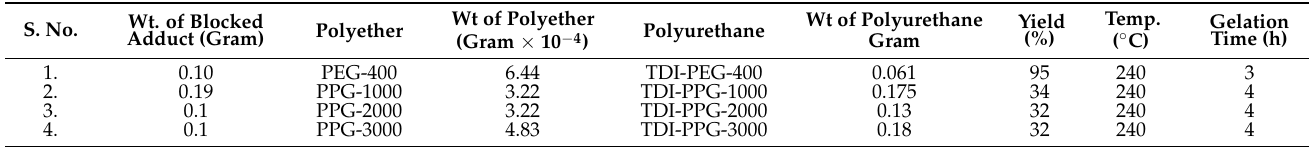
Table 2. Reaction conditions of polyurethane from 4-(3-bromophenyl)-1H-pyrazole-blocked TDI